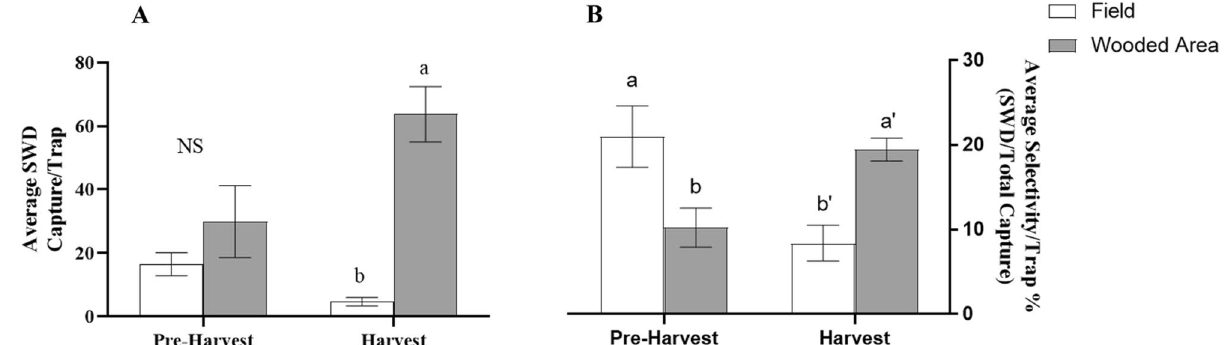
Figure 1. Average capture ( A ) and selectivity ( B ) per dry sticky trap baited with QB during pre-harvest and harvest periods during 2019 in a raspberry field and nearby wooded area within the United States. QB data have been adjusted by the capture amounts in the control dry sticky traps. Means have been separated by two- way ANOVA followed by a Tukey’s post hoc test. Different letters above bars (within harvest periods) indicate significant differences (α = 0.05). Bars represent standard error of the